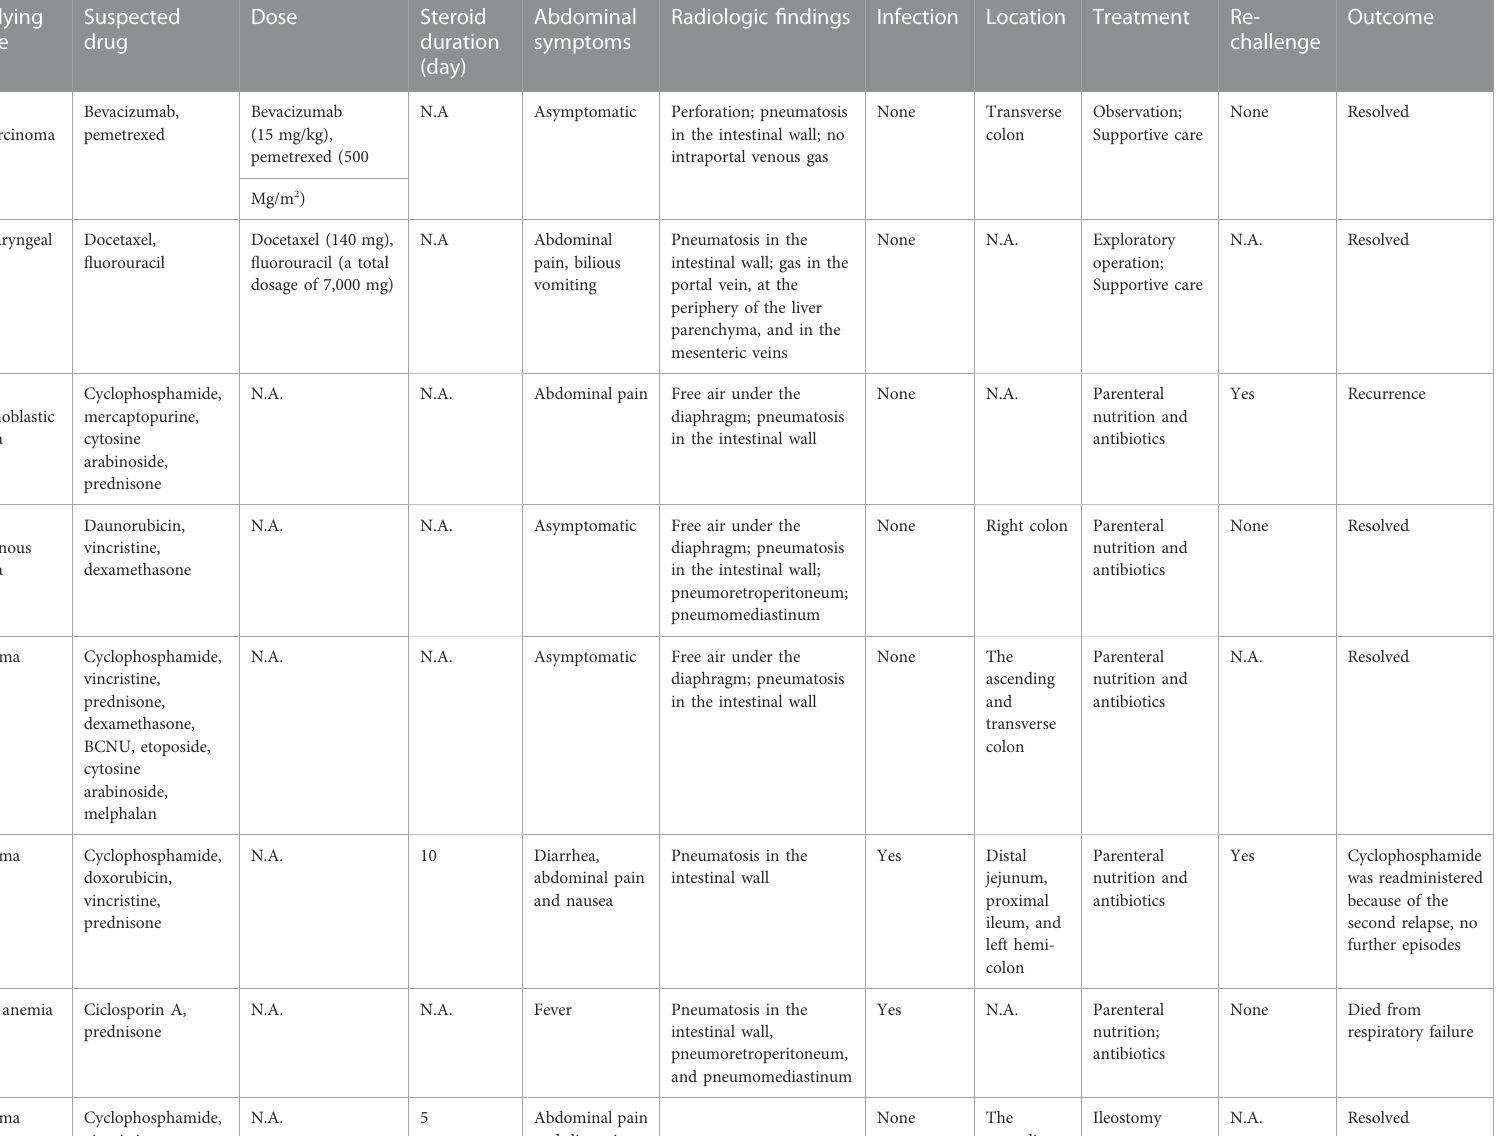
TABLE 1 The information of patients with pneumatosis intestinalis.